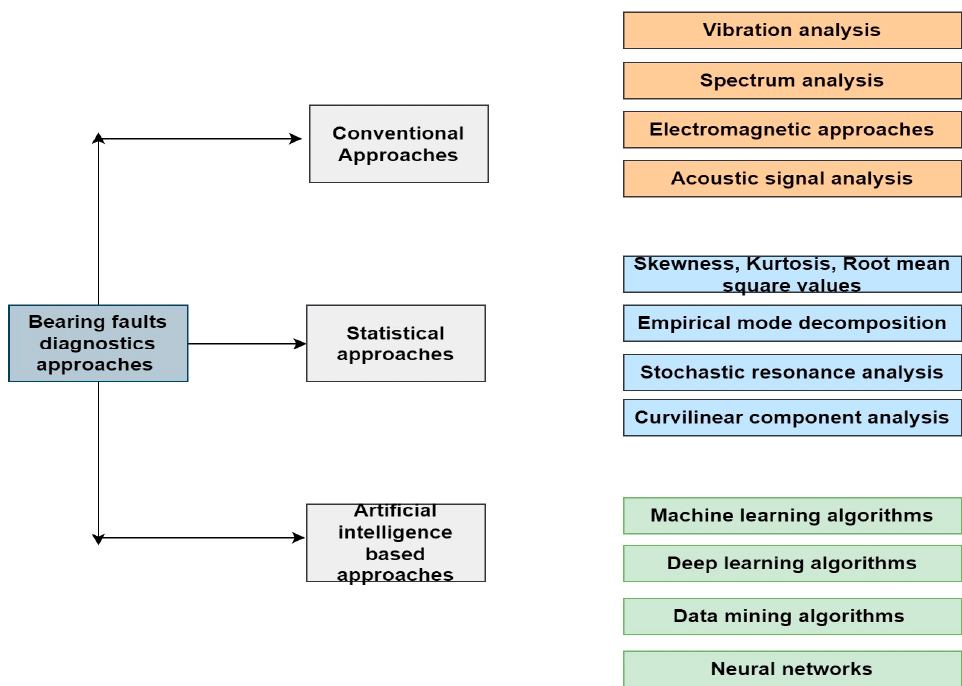
Figure 5. Different bearing fault diagnostic approaches.